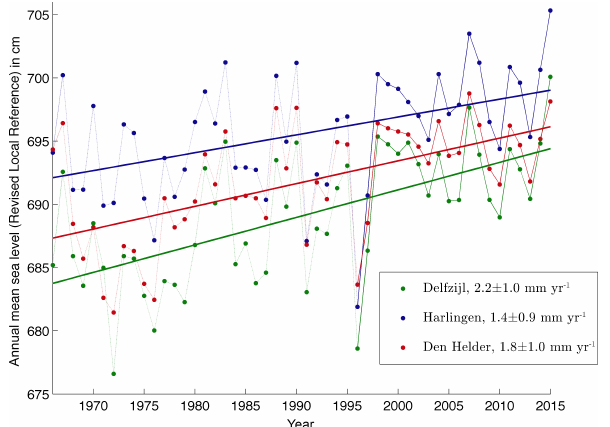
Figure 2. Annual mean sea level at three tide gauges in the Dutch Wadden Sea, during the past half century. The record of the last 20 years is indicated in thin solid lines. The 50-year trend (least squares fit) is plotted in thick solid lines and listed in the legend, together with the 95% confidence interval.